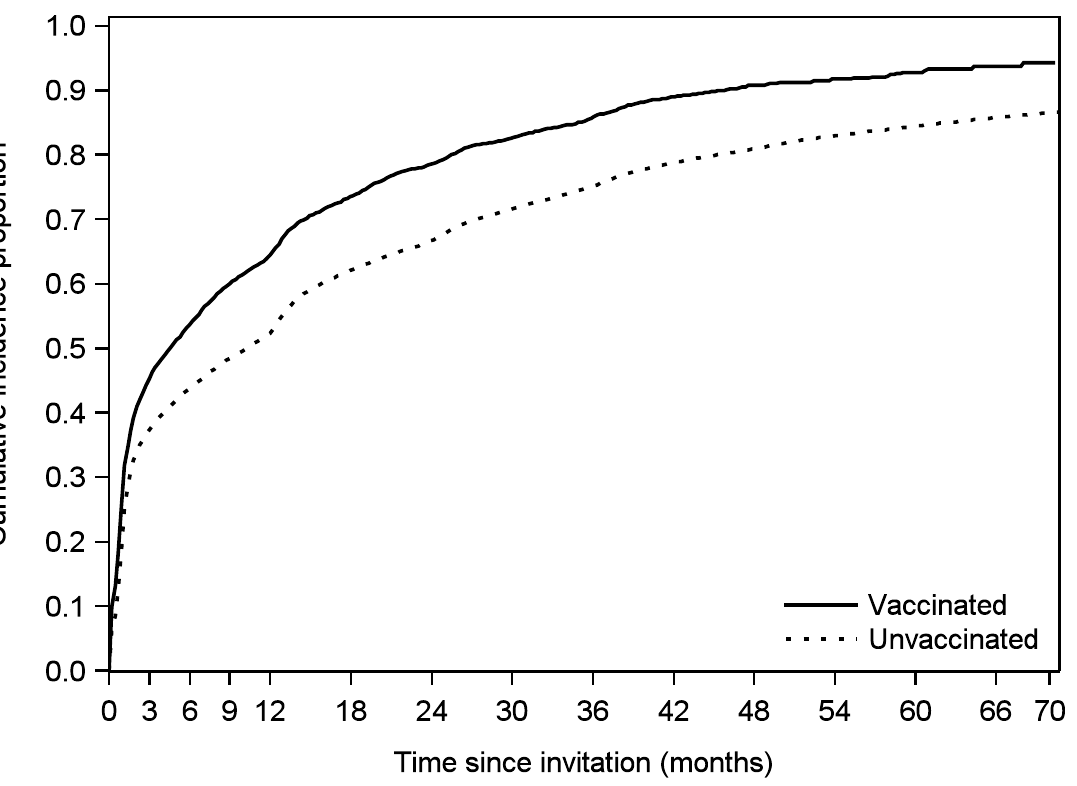
Fig 3. Cumulative incidence proportions of screening attendance since first invitation to screening by vaccination status.